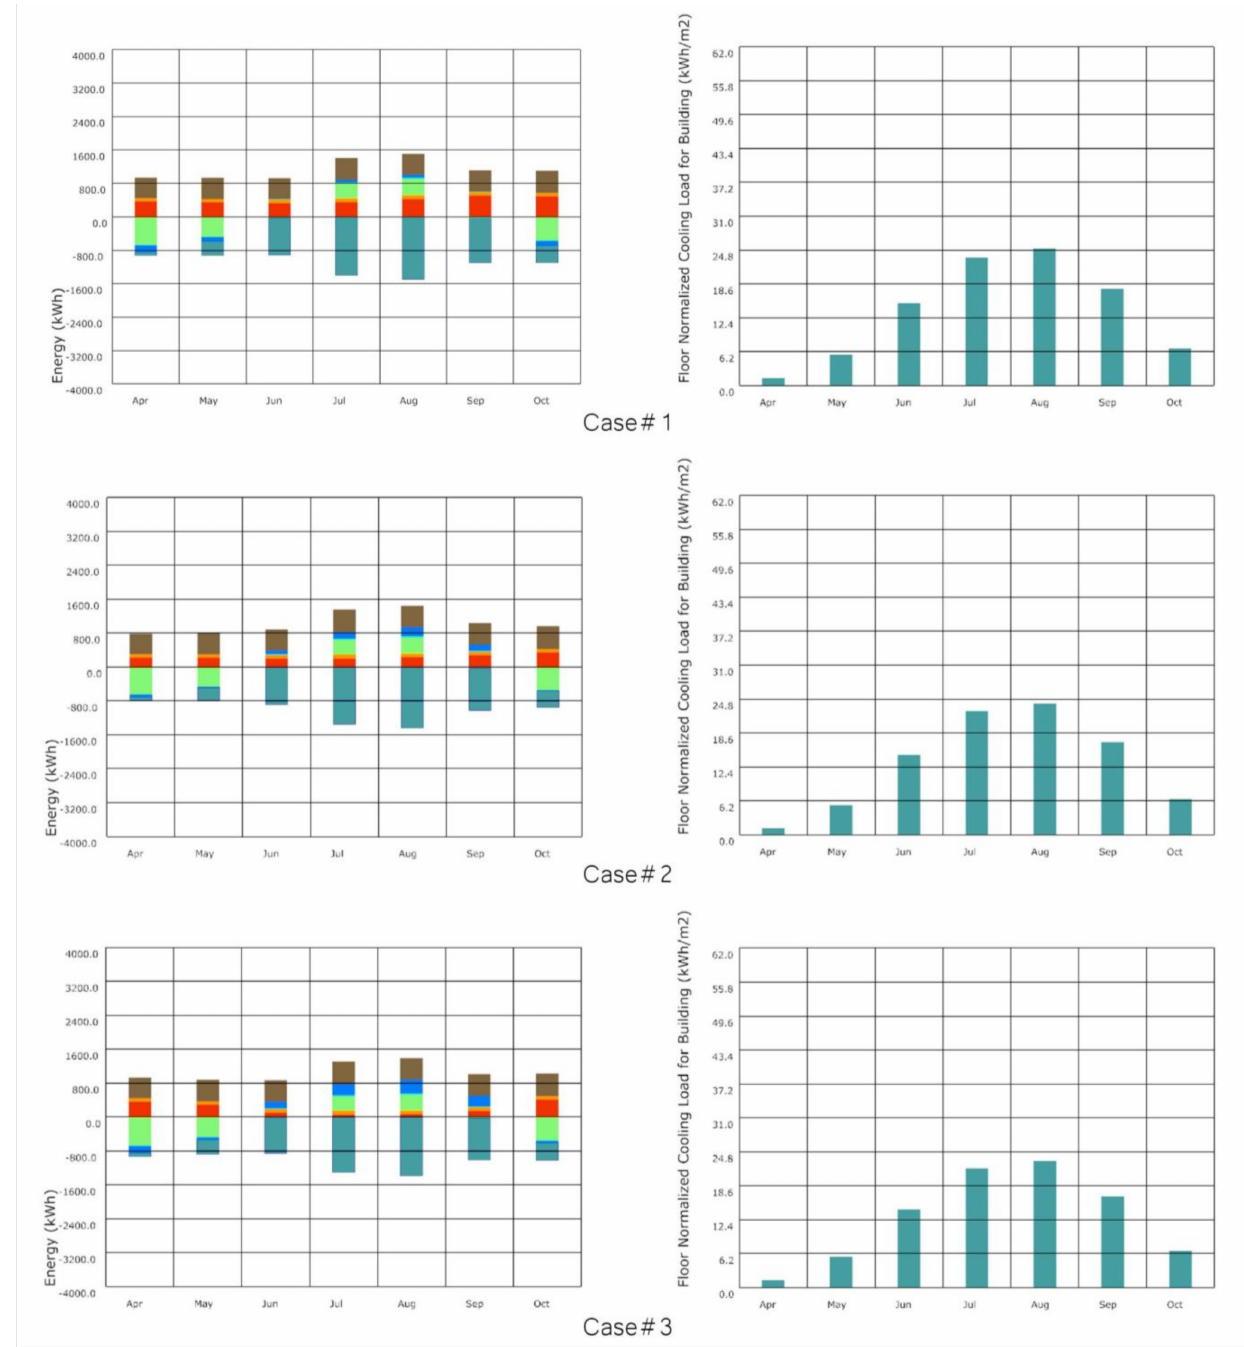
Figure 24. Energy balance charts ( left ) and EUI of the cooling loads charts ( right ) for each case study shown in Figure